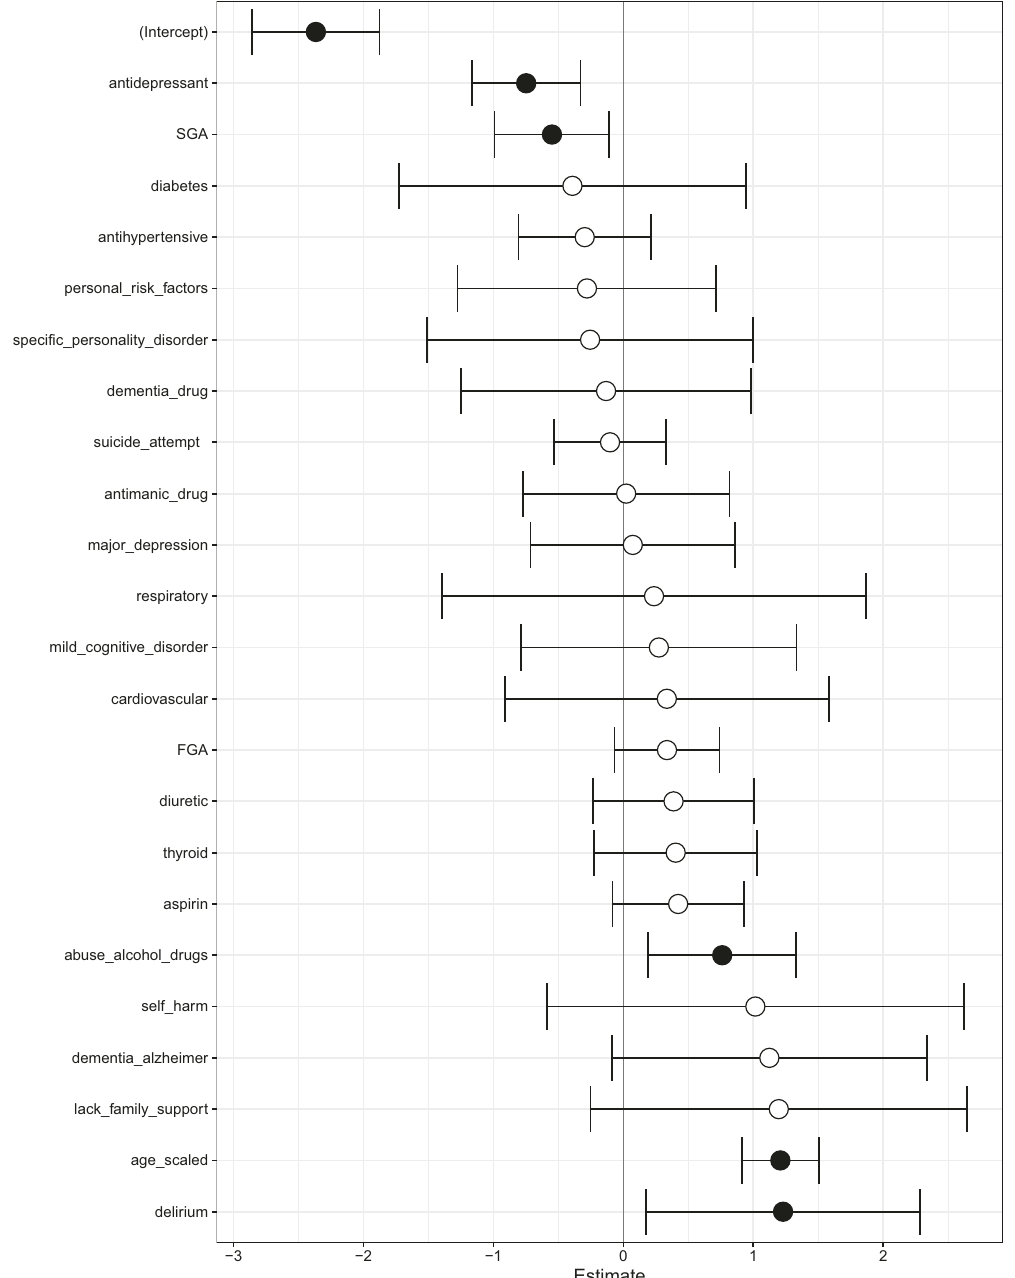
Fig. 3 Logistic regression model to predict mortality in patients with schizophrenia. Log odds ratio of features in a logistic regression model to predict mortality in patients with schizophrenia. Shown are con fi dence intervals and statistical signi fi cance ( fi lled dark circles: p -value < 0.05, open circles: not signi fi cant). Age, alcohol/substance abuse and a diagnosis of delirium were associated with a high risk of death. The use of second-generation antipsychotics (SGA) and antidepressants were associated with reduced risk of